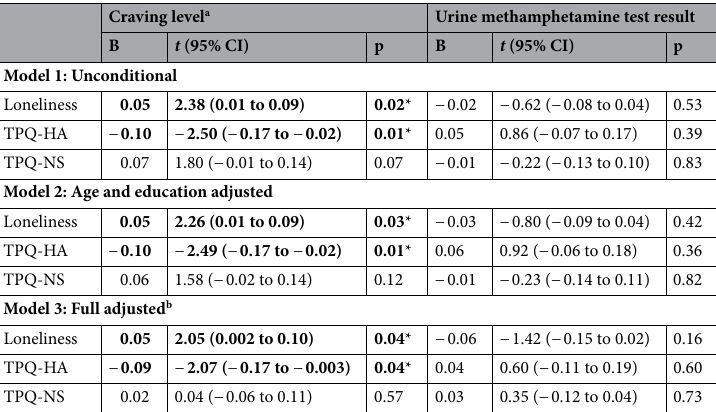
Table 2. Association between loneliness, personality traits, and craving level for methamphetamine, and the urinary methamphetamine test results at first stage in methamphetamine-use patients. *p < 0.05, **p < 0.01. TPQ tridimensional personality questionnaire, HA harm avoidance, NS novelty seeking. a Transformed VAS by log (x + 1). b Model 3: adjusting for age, education, disease duration (years), psychiatric comorbidities, measure of support function (MSF), Hamilton depression rating scale (HDRS), family adaptation, partnership, growth, affection, and resolve index (family APGAR), and the numbers of visits.